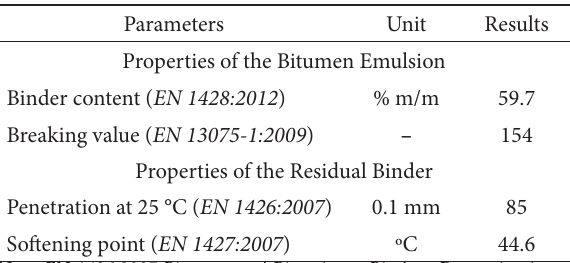
Table 2. Parameters of bitumen emulsion (C60B5R) and the residual binder Parameters Unit